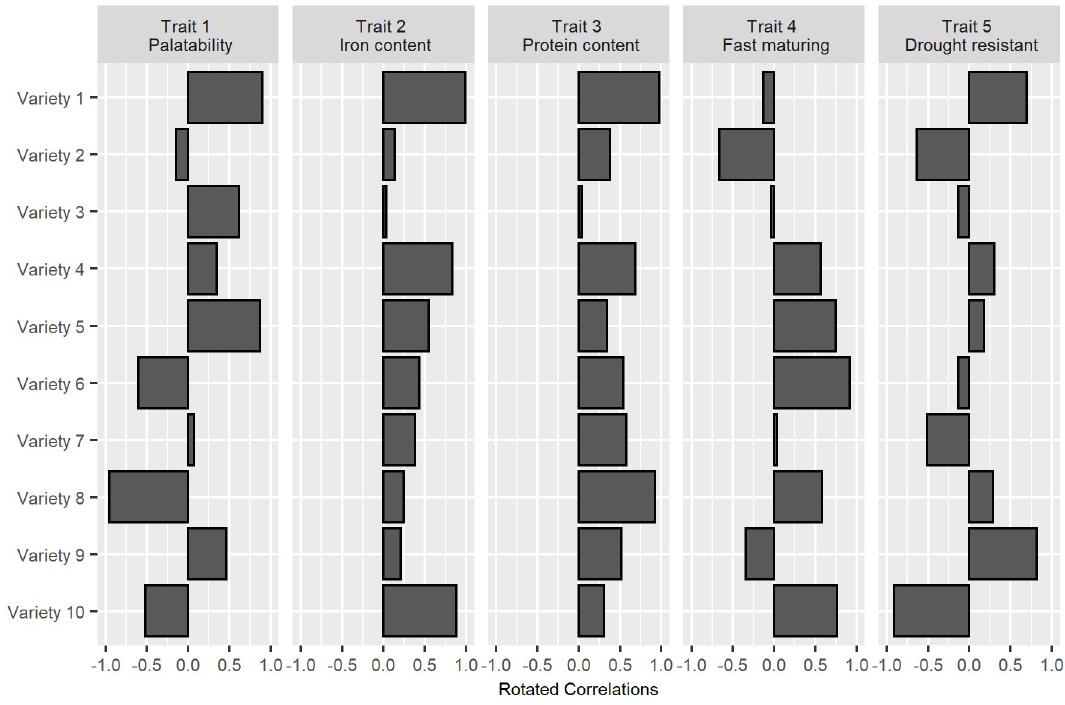
Fig 9. Hypothetical example of crowdsourced, orthonormally rotated trait-variety correlations.